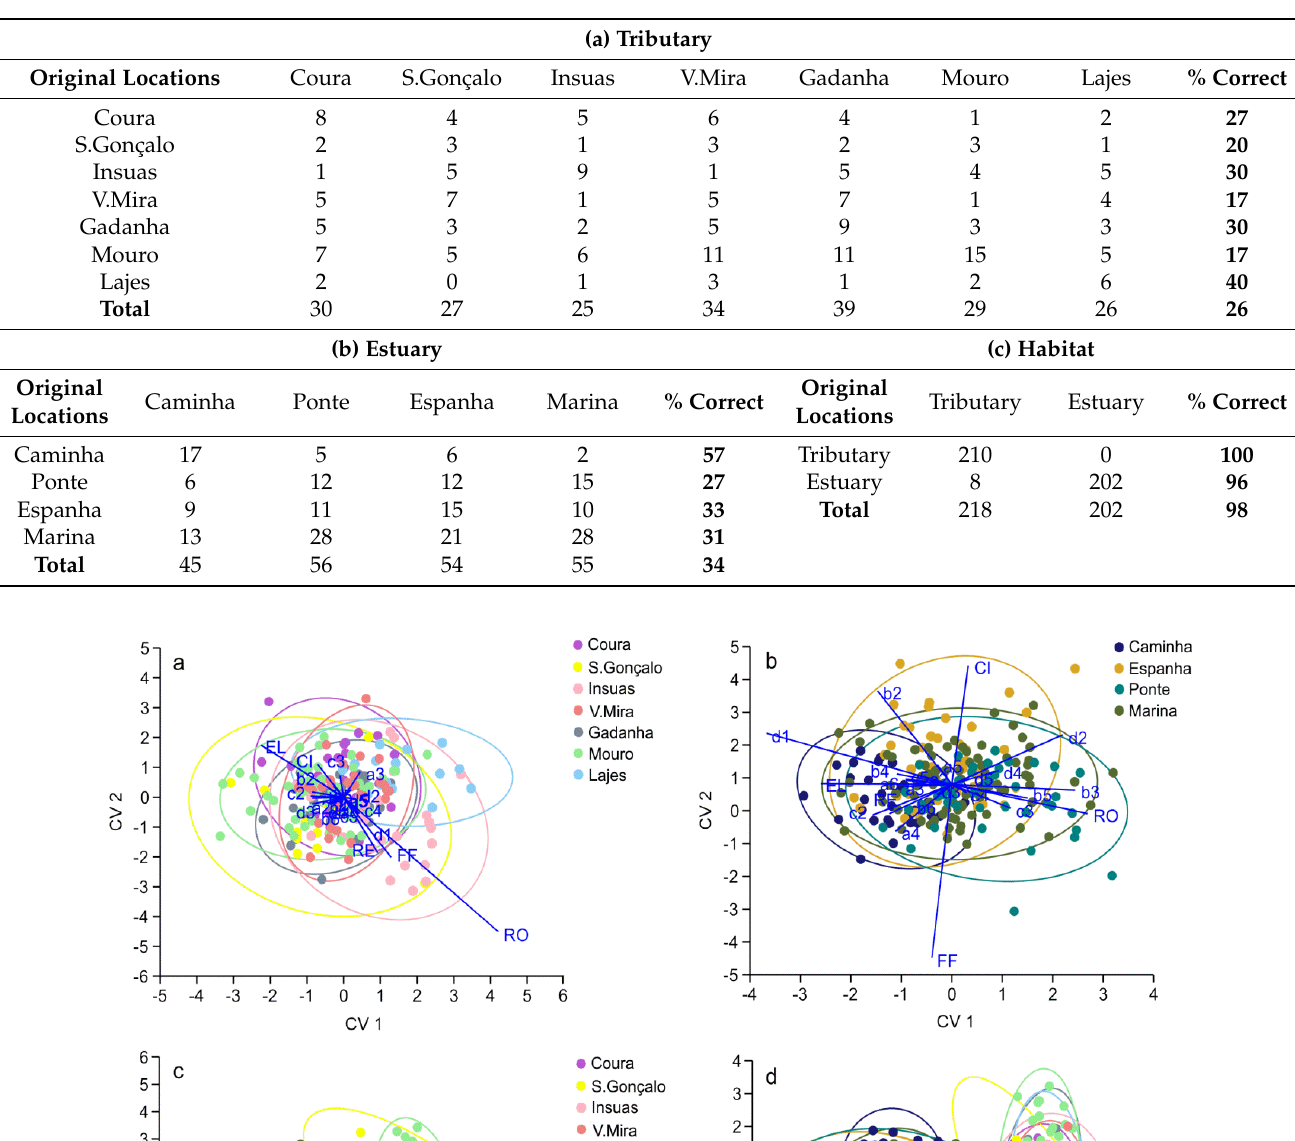
Table 3. Jackknife reclassification matrix of the otolith shape signatures of the eels collected in the Minho River according to (a) the tributary sampling locations, (b) the estuary sampling locations, and (c) habitat.